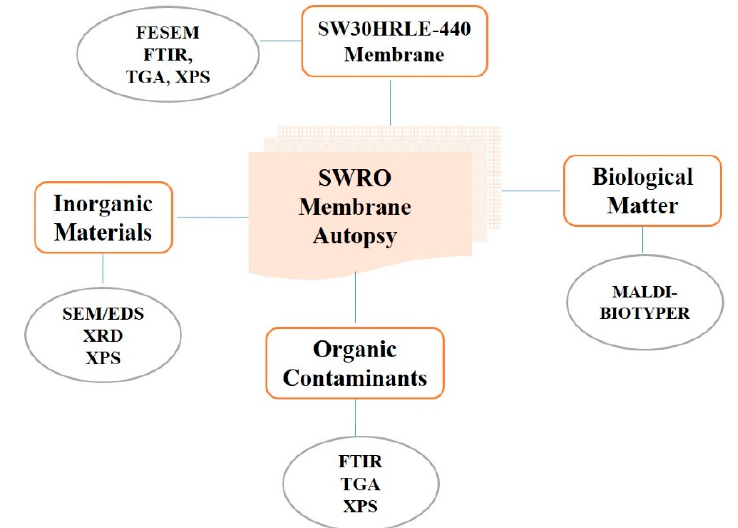
Figure 1. Conceptual visualization of SWRO membrane autopsy.